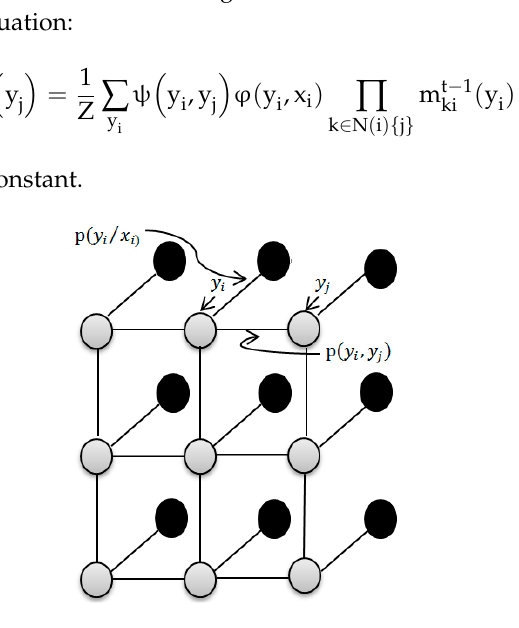
Figure 1. Graph example of MRF.